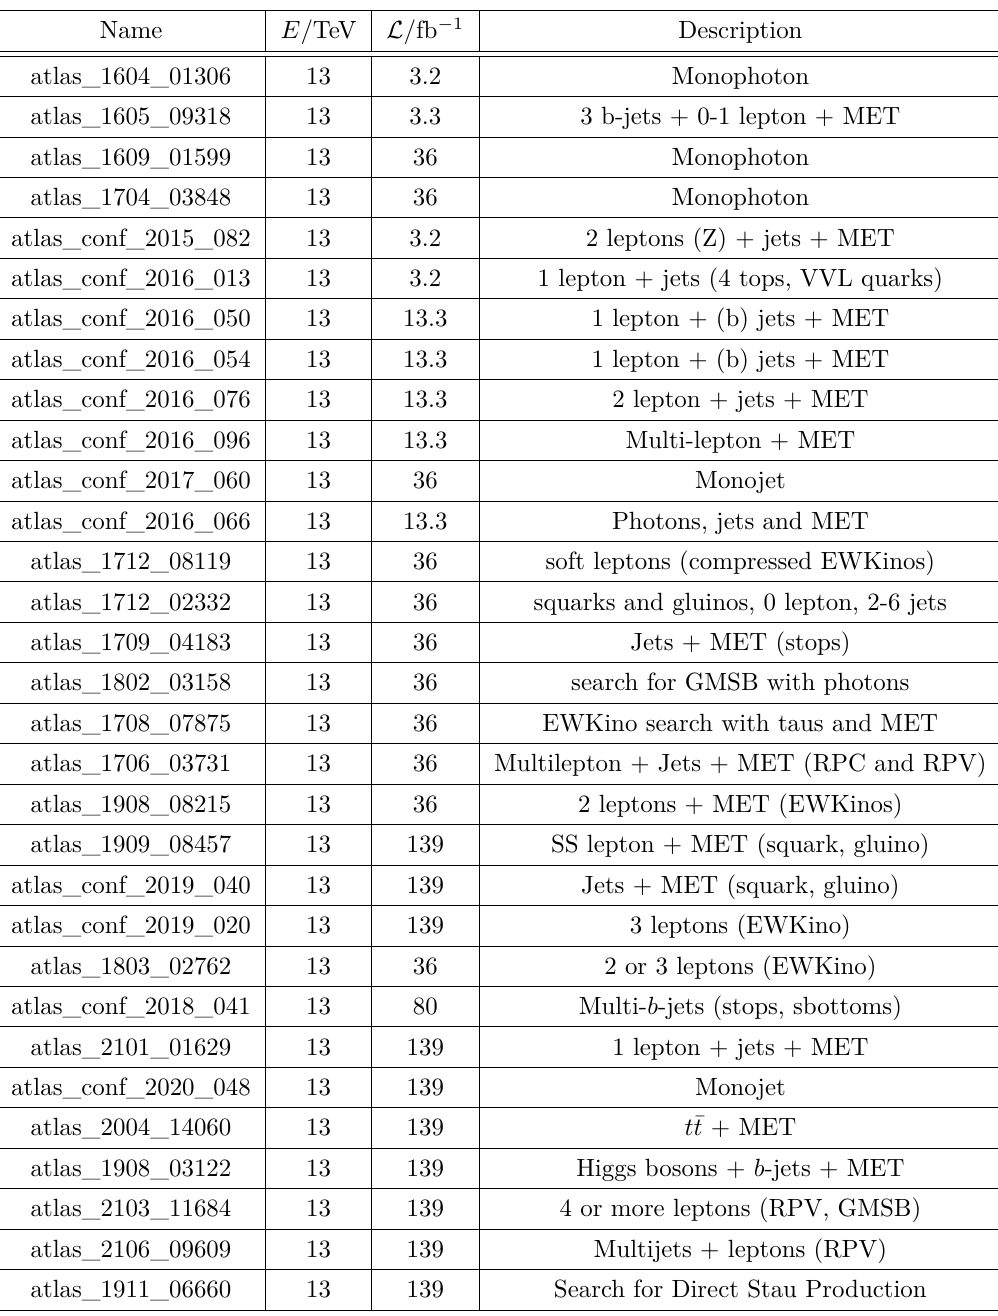
Table 6 . List of 13 TeV ATLAS analyses available in CheckMATE and which have been validated against published experimental